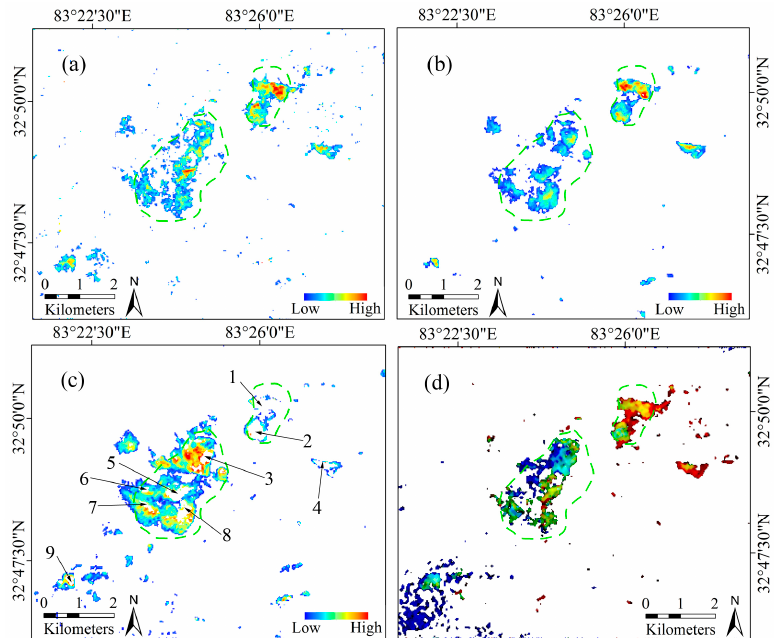
Figure 7. The abundance of Al-OH group minerals of Duolong PCD. ( a ) Al-OH 1 , ASTER RBD (B5 + B7)/B6 (Threshold 94.6%); ( b ) Al-OH 2 , ASTER SWIR bands MTMF (Infeasibility < 5); ( c ) Al-OH 3 , ASTER SWIR bands MTMF (Infeasibility < 5); ( d ) False color composite image of Al-OH composition in ASTER BRs B5/B6 (R), B7/B6 (G), B7/B5 (B) (Threshold 97.5%). The green dotted line shows the